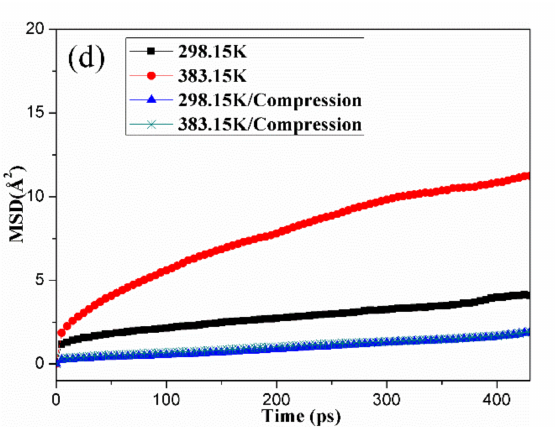
Figure 5. Changes in mean square displacement (MSD) of rubber molecule chains in unaged and aged NBR models under different conditions: ( a ) NBR; ( b ) OH-NBR; ( c ) CO-NBR; ( d )